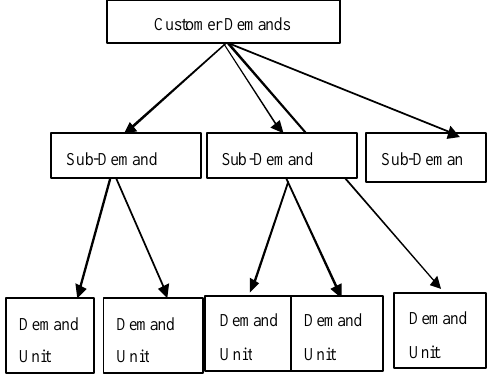
Fig.1. Demand unit analysis tree